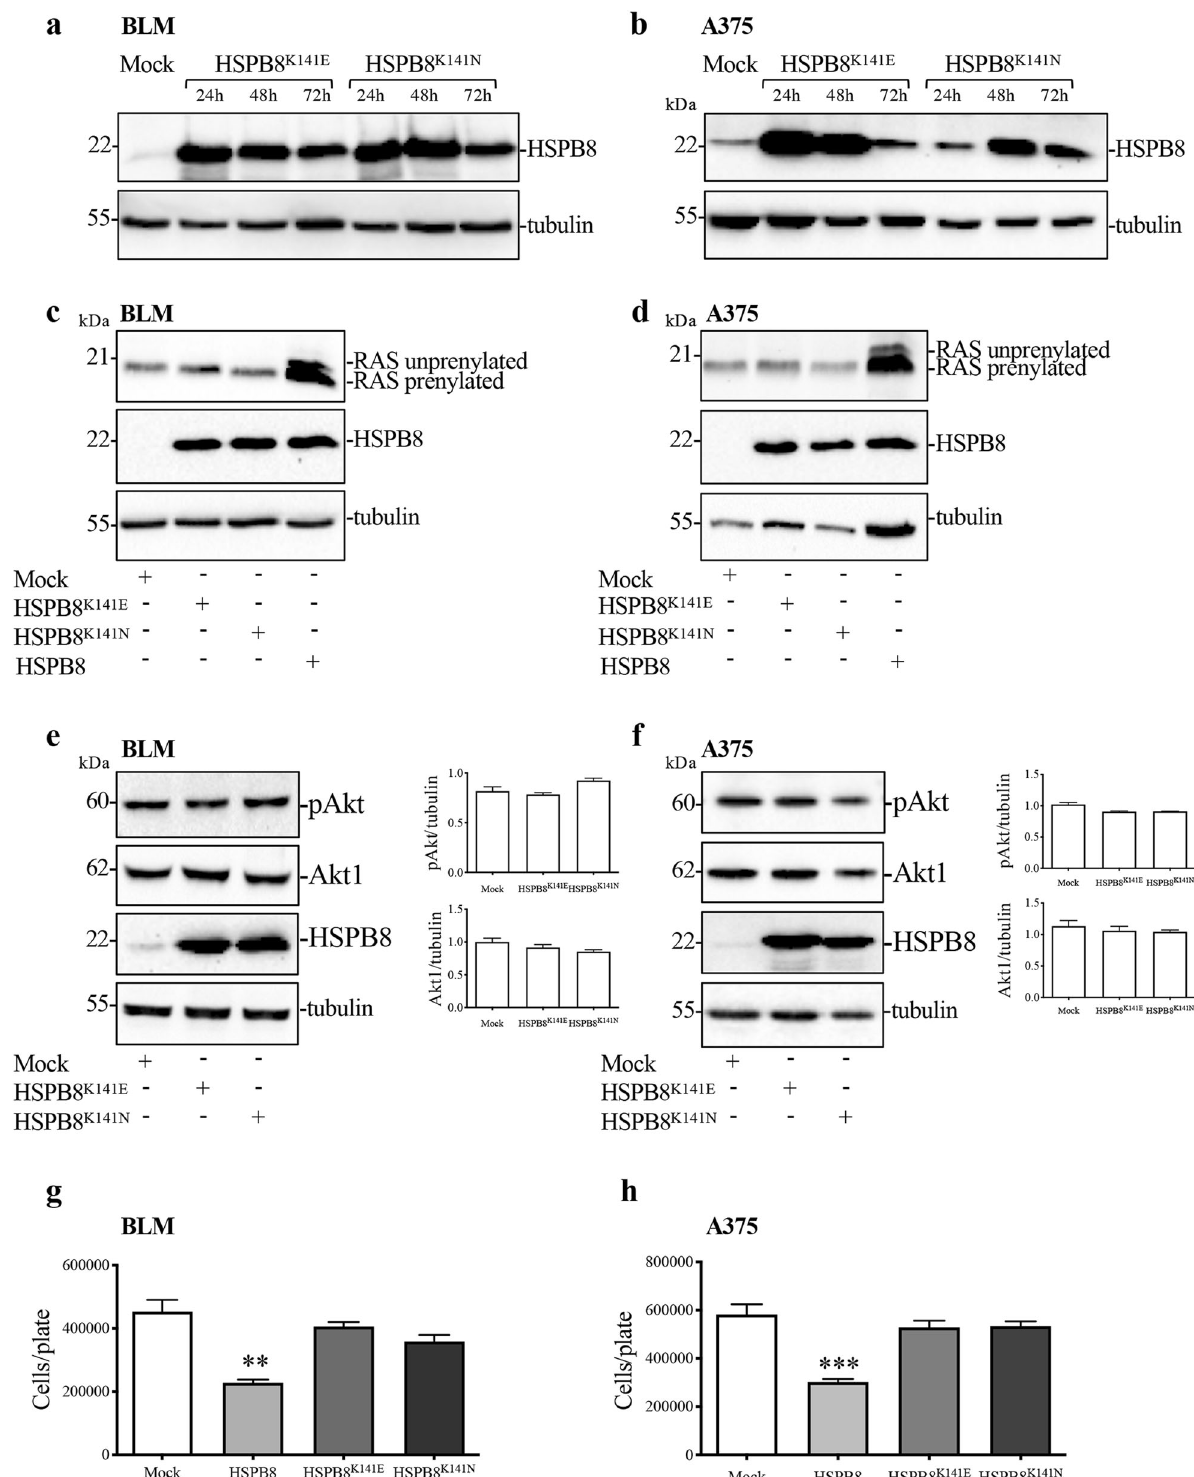
Fig. 5 Effect of HSPB8 K141E and HSPB8 K141N overexpression on NRAS pathway in BLM and A375 cells. a , b WB analysis of HSPB8 in BLM ( a ) and A375 ( b ) cells overexpressing HSPB8 K141E and HSPB8 K141N for 24, 48, and 72 h. c , d WB analysis of RAS protein levels in BLM ( c ) and A375 cells ( d ) overexpressing HSPB8 K141E , HSPB8 K141N , and HSPB8 (48 h). e , f Effect of mutant HSPB8 overexpression (48 h) on Akt and p-Akt in BLM ( e ) and A375 ( f ) cells. Tubulin was used as loading control. Three independent biological samples for each condition were analyzed ( N = 3), bar graph represents the mean optical density ± SD. g , h Cell count assay was performed in BLM ( g ) and A375 cells ( h ) expressing mutant HSPB8 (48 h). Four independent biological samples for each condition were analyzed ( N = 4), bar graph represents the mean relative cell viability ± SD. Statistical analysis was performed using Student ’ s t -test (** p < 0.01 vs. mock; (*** p < 0.001 vs. mock).